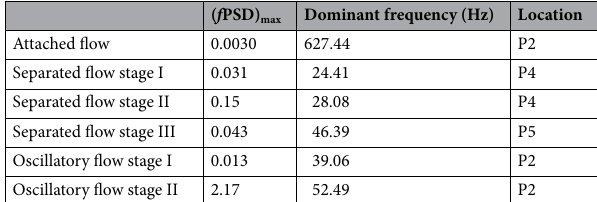
Table 2. Spectral evolution of pressure fluctuations on pressure surface during throttling